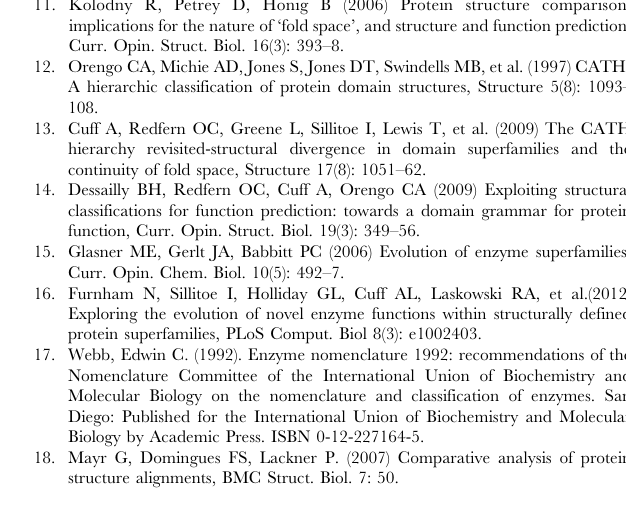
Figure S1 Flowchart explaining the types of outliers.